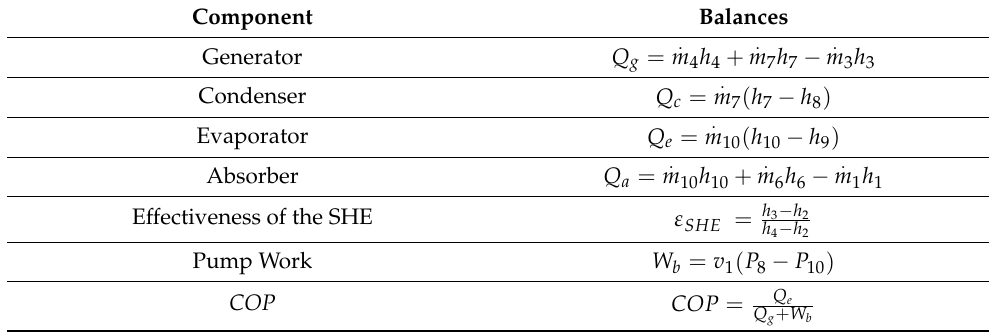
Table A1. Energy balances for each one of the components of the single-effect absorption cooling